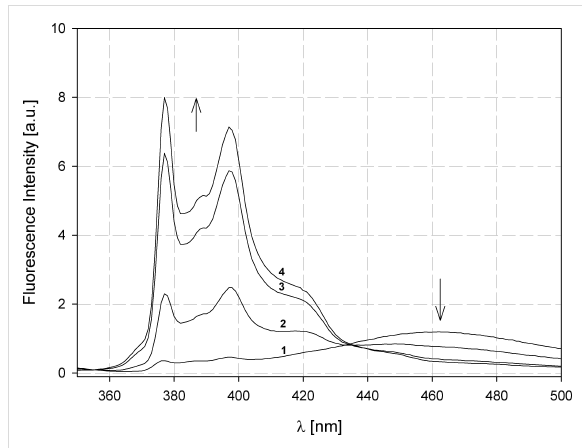
Figure 7: Influence of Triton X-100 on the fluorescence spectra of 32a in aqueous solution. 32a was added from a stock solution in MeOH to HBS giving a concentration of 2 µM. The fluorescence spectra ( λ ex = 340 nm) were recorded in the absence (line 1) or in the pres- ence of Triton X-100 at 0.007 % (w/v) (line 2); 0.013 % (w/v) (line 3) and 0.02 % (w/v) (line 4) at 37 °C.